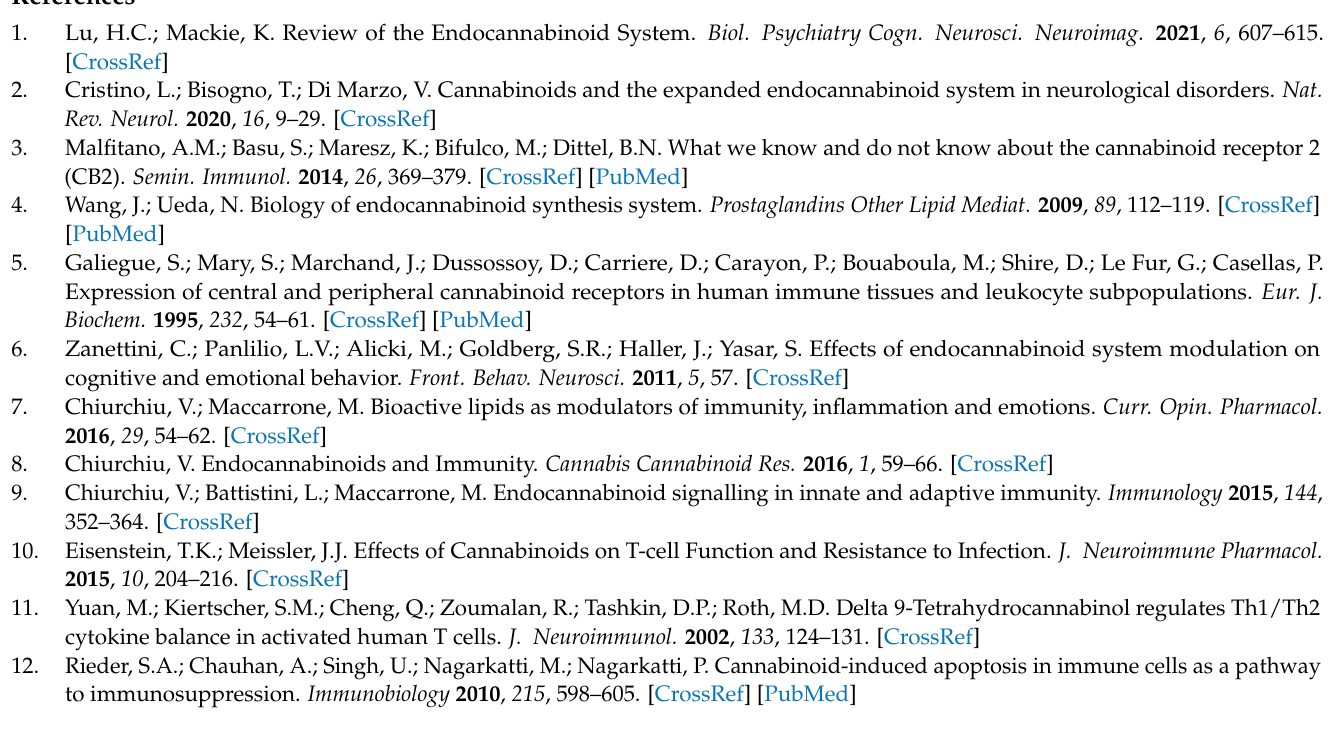
activation markers; Figure S2: Gating strategy for analysis of co-stimulatory molecules expressed on monocytes and B cells; Figure S3: Gating strategy and a representative flow cytometric data of cytotoxic function of CD8 + T cells; Figure S4: Gating strategy for analysis of LAMP-1 and IFN- γ positive cells; Figure S5: Gating strategy and a representative flow cytometric data of T helper cytokines; Figure S6: Investigation of toxicity of CB1 and CB2 agonists on T cell proliferation; Figure S7: A representative flow cytometric data of cytotoxic function of CD8 + T cells; Figure S8: Effect of CB1 and CB2 agonists on cytotoxic function of NK